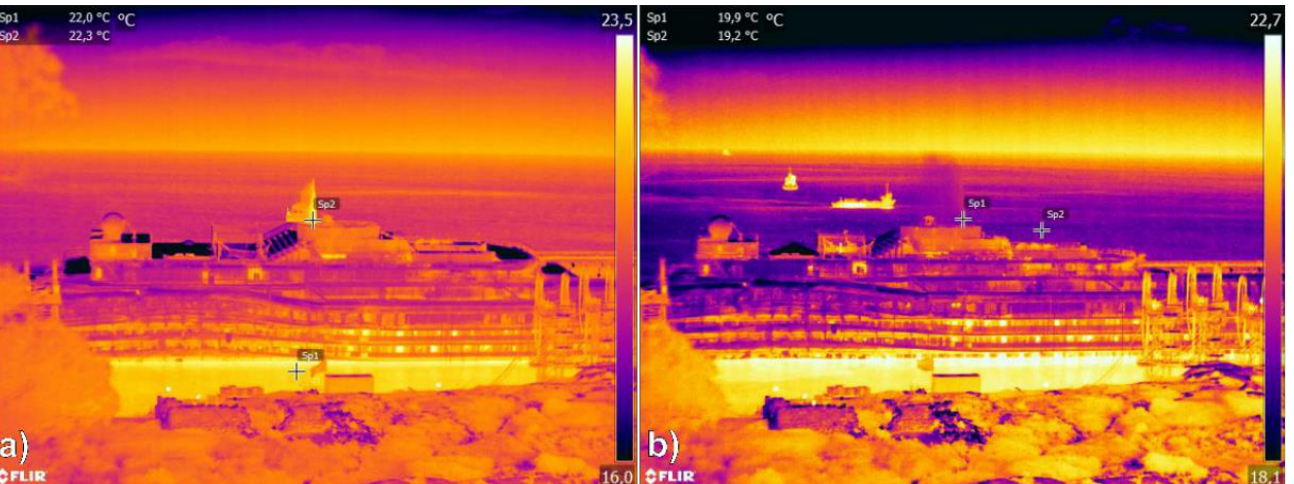
Figure 5. Thermograms selected from the IR video sequence acquired during the parbuckling (colorbar “iron”). Thermogram acquired at 02:42 on 17 September 2013 ( a ); thermogram acquired the same day at 04:12 ( b ) (Sp1 – 2 represent the spot measurements of single pixels).